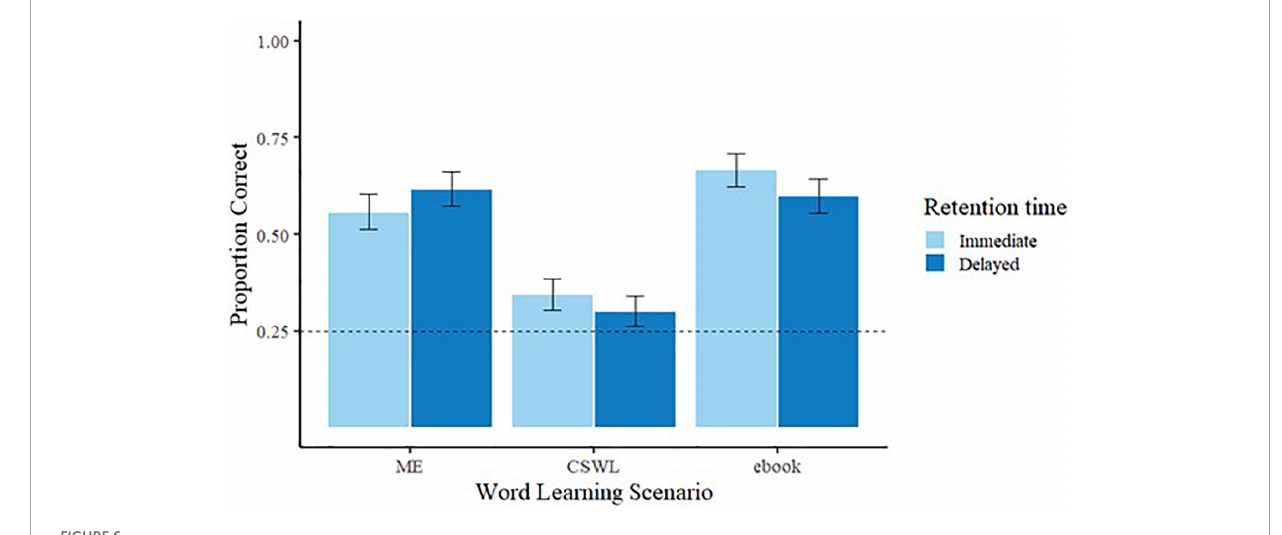
FIGURE6 Immediate and delayed retention accuracy across word-learning scenarios (error bars display the standard error of the mean).